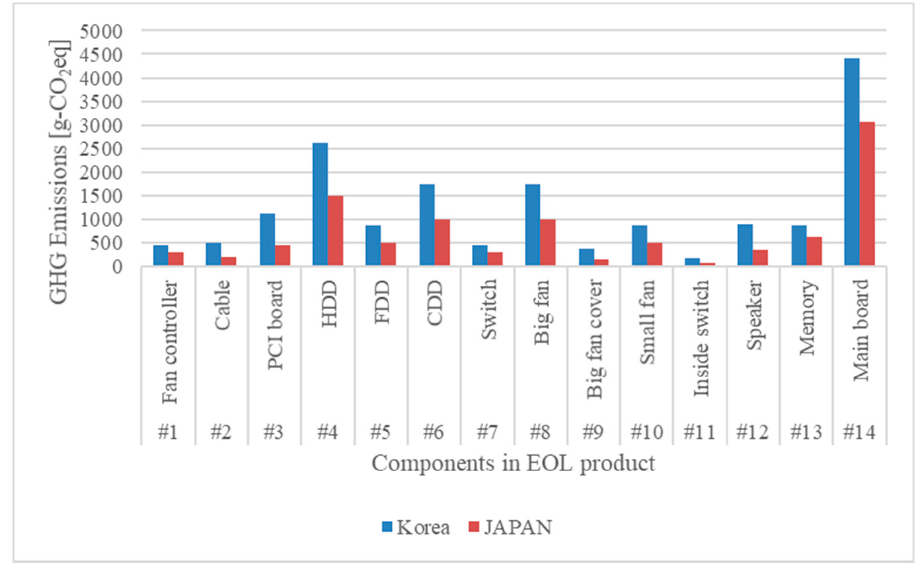
Figure 3. Comparison of GHG emissions of each component in Korea and